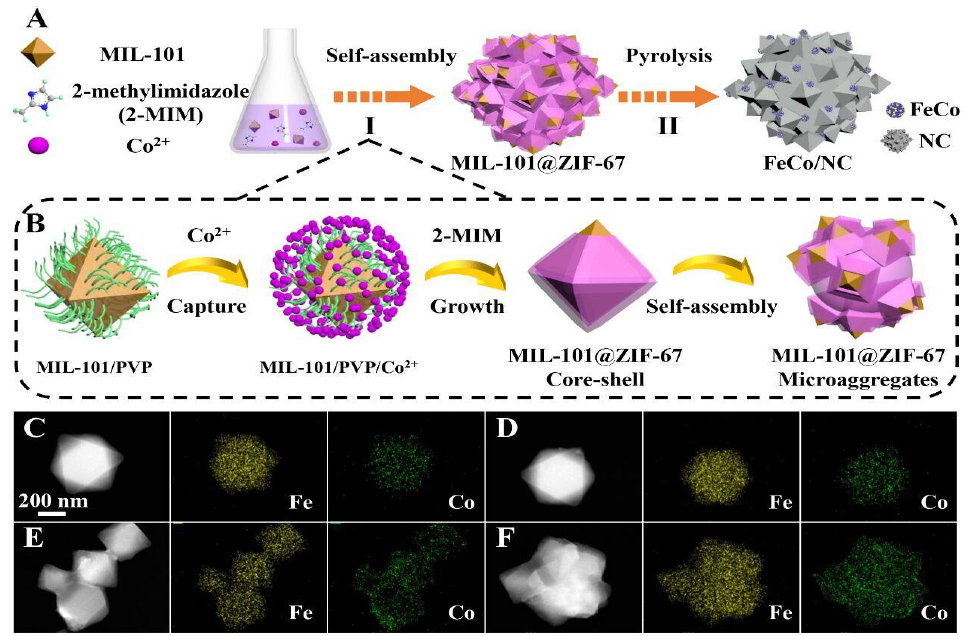
Figure 14. ( A ) Diagram of FeCo/NC catalyst synthesis. ( B ) Schematic diagram of the ligand-induced self-assembly process. ( C ) TEM images of the intermediates after ( C ) 2 min, ( D ) 5 min, ( E ) 10 min, and ( F ) 20 min. (Reprinted with permission from [207]. Copyright 2022, John Wiley and Sons).